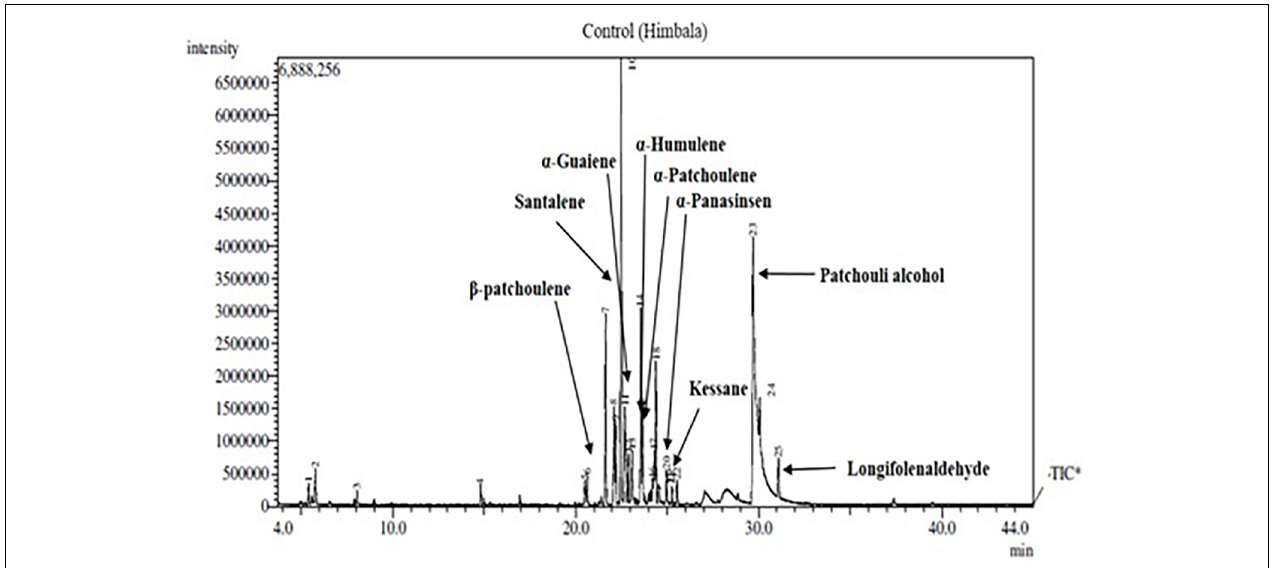
FIGURE 6 | Chromatograms of essential oil sample of Himbala.